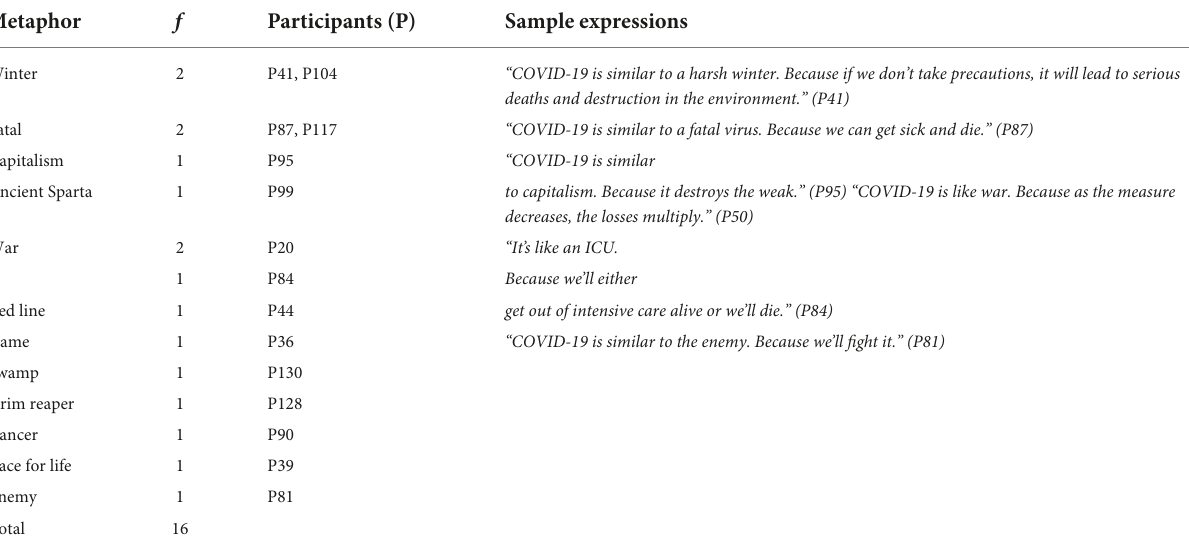
TABLE 8 Struggle